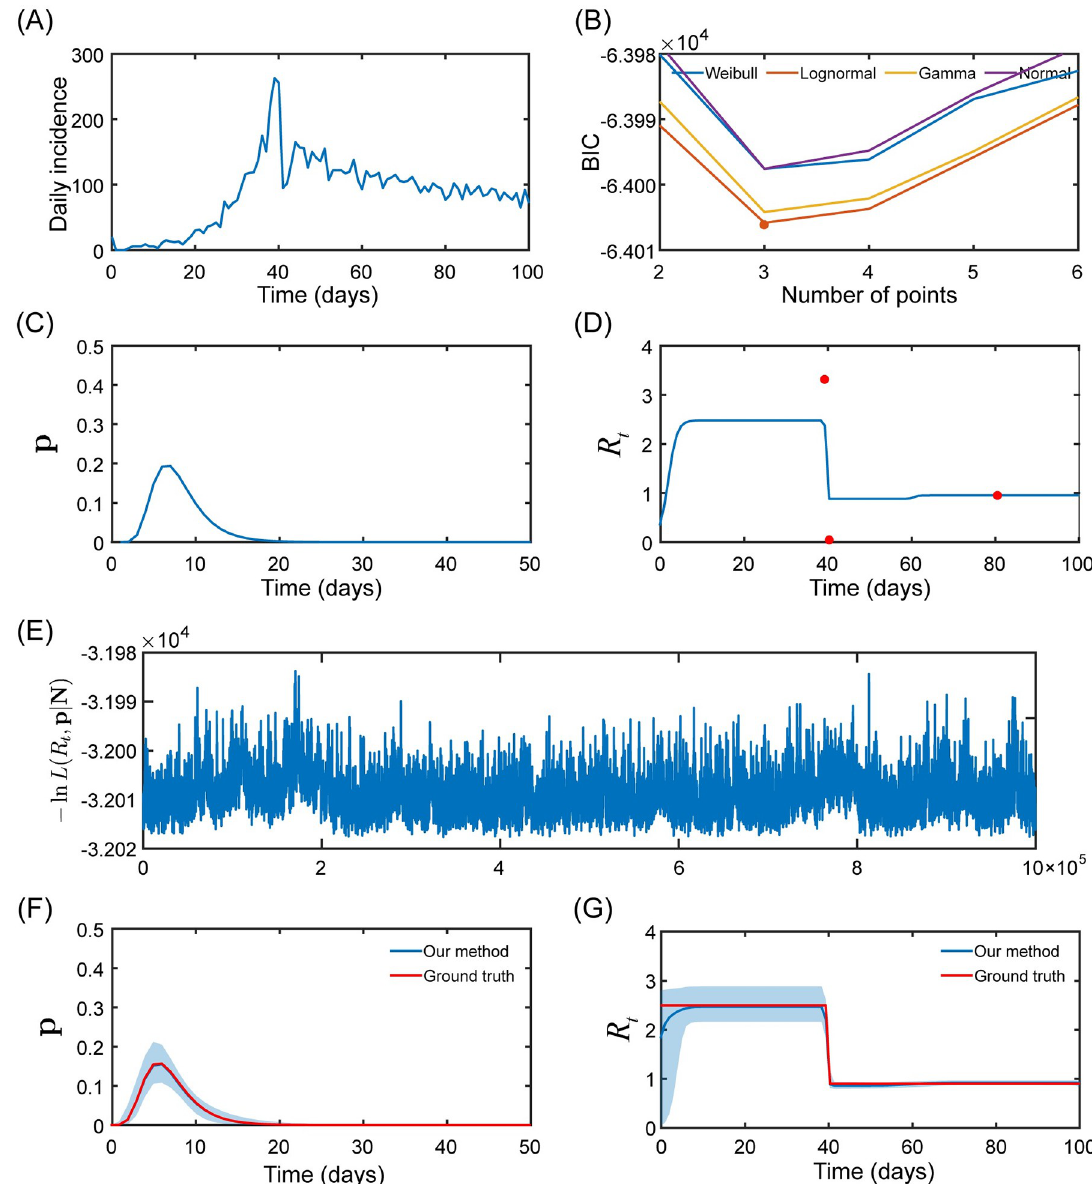
Fig 2. An example illustrating the workflow of our method. The time series of daily incidence (A) was simulated according to the conditions of scenario one. Using the BIC (B), the number of data points and serial interval distribution were determined, and the serial interval (C) and instantaneous reproductive number (D) were obtained. The MCMC method (E) was then used to generate the distribution of the serial interval (F) and instantaneous reproductive number (G). BIC: Bayesian information criterion; MCMC: Markov Chain Monte